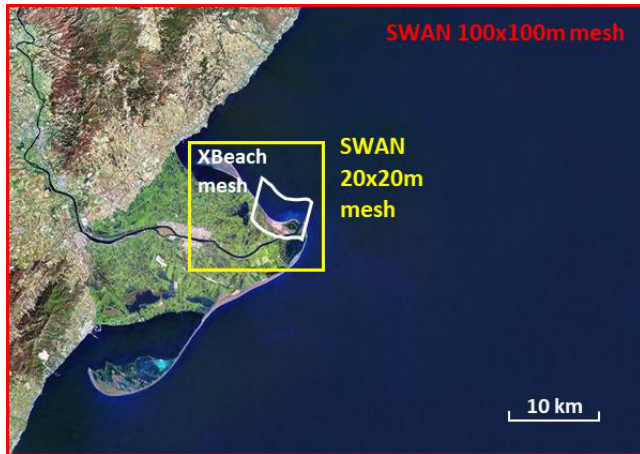
Figure 4. Location of the computational meshes used to run SWAN (red, coarse mesh; yellow, fine mesh) and XBeach (white, local mesh) models. Modified from ICGC (http://www.icc.cat/vissir3/).